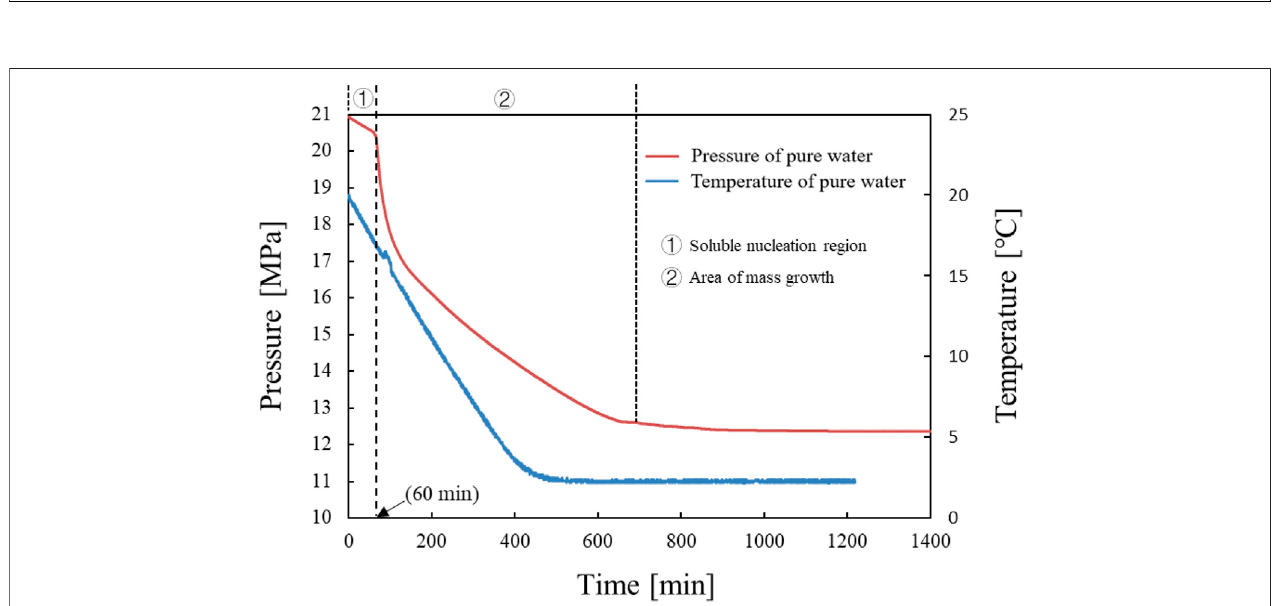
FIGURE 2 | Temperature and pressure pro fi les for hydrate formation in the pure water system.